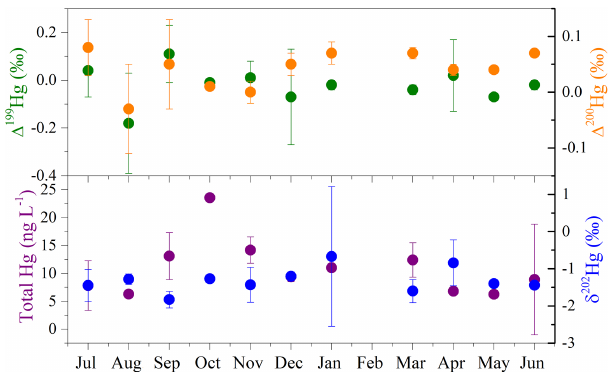
Figure 5. Monthly variations in the total Hg concentration, δ 202 Hg, (cid:49) 199 Hg, and (cid:49) 200 Hg of surface seawater during the sampling pe- riod from July 2017 to June 2018.